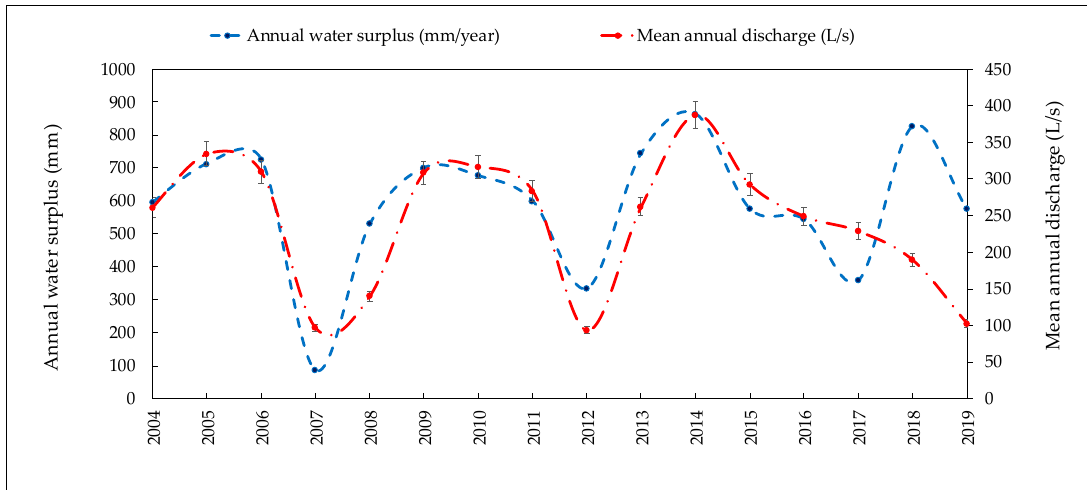
Figure 6. Annual water surplus and mean annual discharge from October 2003 to September 2019.